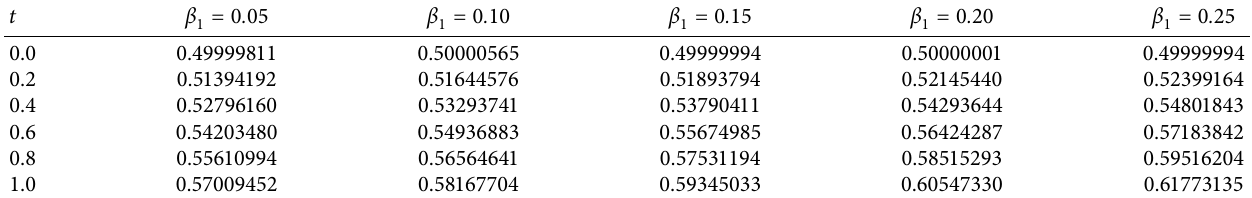
Table 12: Approximate solutions obtained by the LeNN-WOA-NM algorithm for population density of local prey S ( t ) under the influence . of β 1